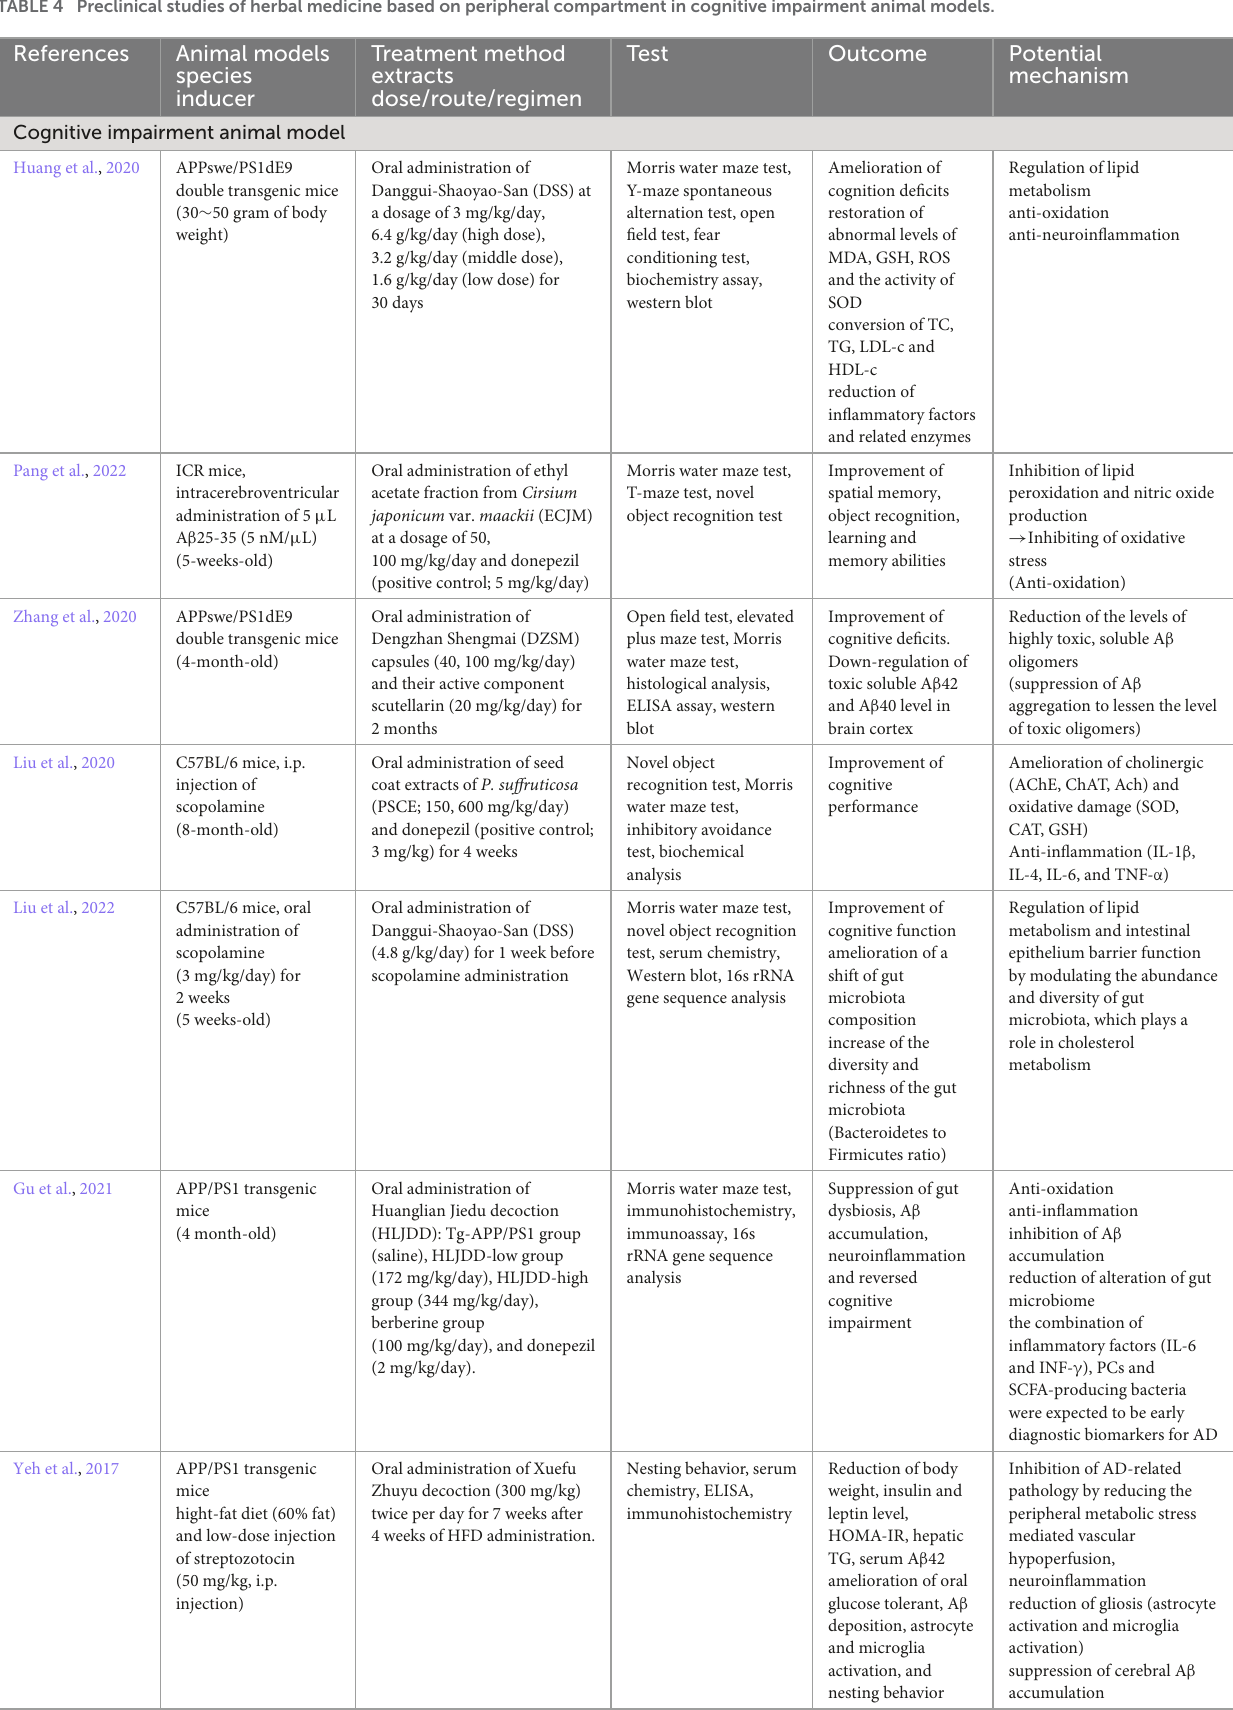
TABLE 4 Preclinical studies of herbal medicine based on peripheral compartment in cognitive impairment animal